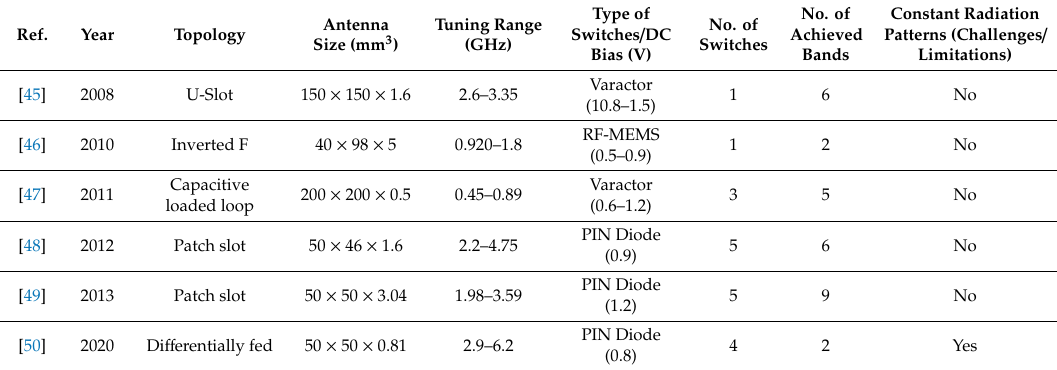
Table 2. Performance comparison between the surveyed reconfigurable